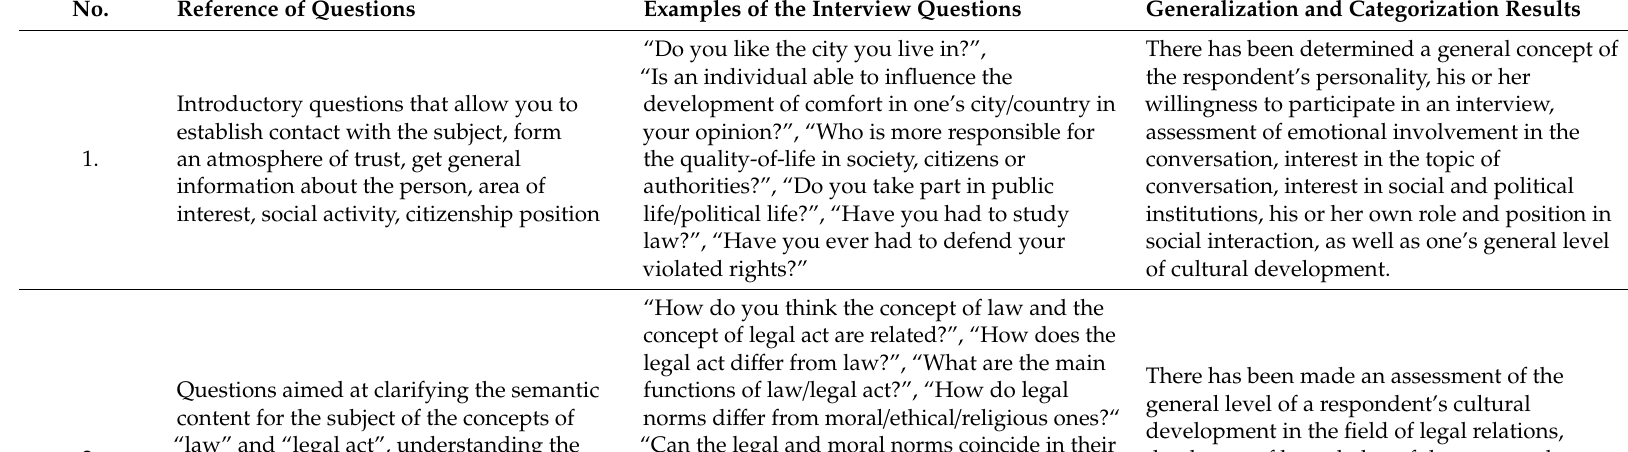
Table 1. Interview structure